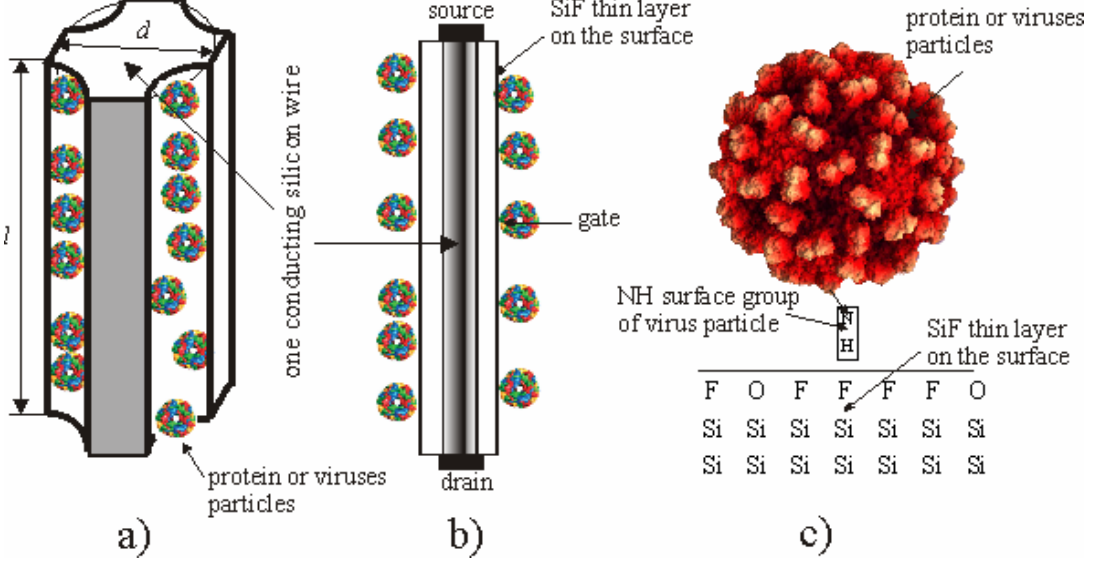
Figure 5. Illustrations of filling of a porous silicon wire surface with the adsorbed virus particles (a) and (b), and interaction between polar molecules on the surface of a capsid and the F-Si-H group on porous silicon surface